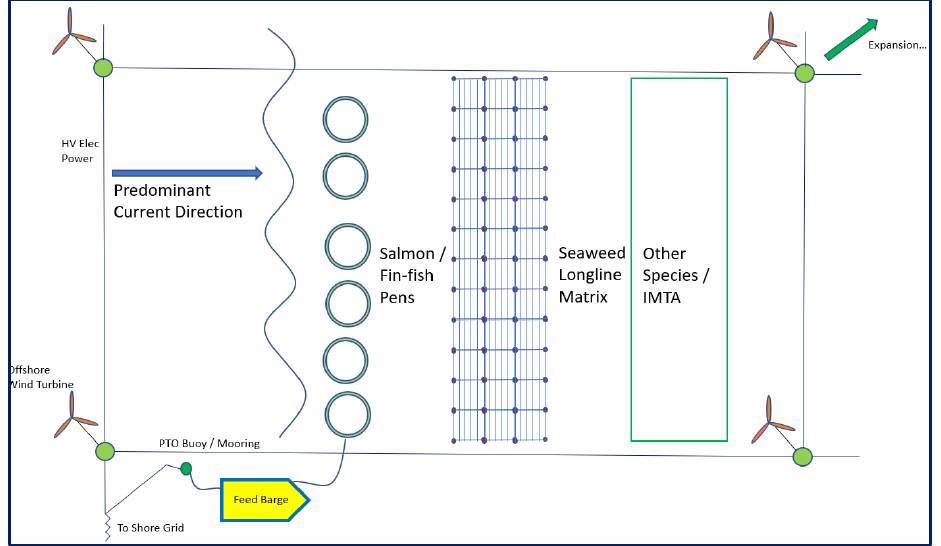
Figure 29. Grid connected offshore wind powered—IMTA, seaweed system concept.